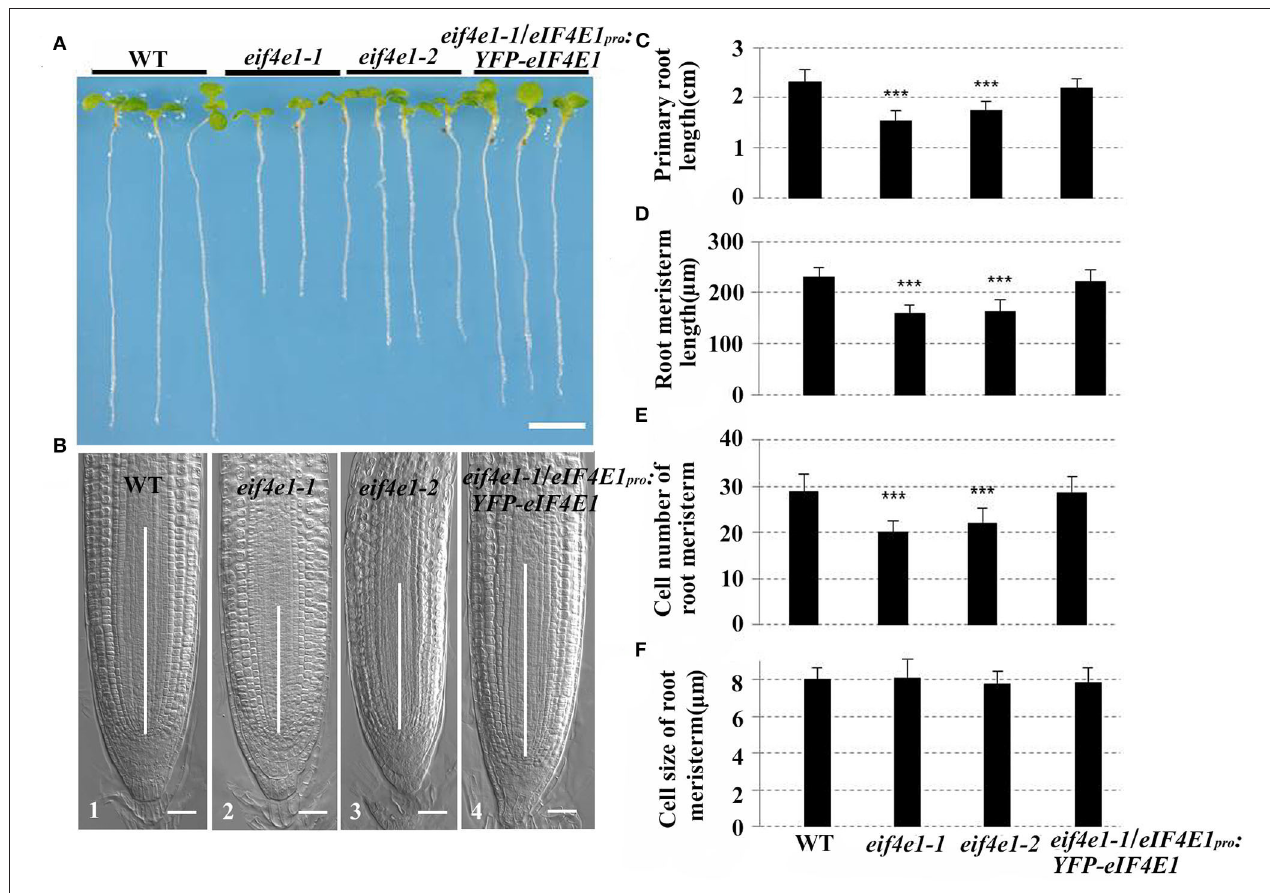
FIGURE 3 | eIF4E1 mutation affects primary root growth. (A) Six-day-old seedlings of wild-type, eif4e1-1 , eif4e1-2 , and complementary line (transgenic plants harboring eIF4E1 pro :YFP-eIF4E1 vector in the eif4e1-1 background). (B) Comparison of RM region of 6-day-old Arabidopsis among wild type (B1), eif4e1-1 (B2), eif4e1-2 (B3), and eif4e1-1 / eIF4E1 pro :YFP-eIF4E1 (B4). White lines in the middle of root tips indicate the length of RM. (C–F) Root analysis of 6-day-old seedlings. Length of primary root (C) and RM (D) , cell number of RM (E) , and cell size of RM (F) . Data are presented as mean values with SD, n > 60. The asterisks indicate significant difference by Student’s t -test (*** P < 0.001). Scale bars: (A) 4mm; (B) 20 µ